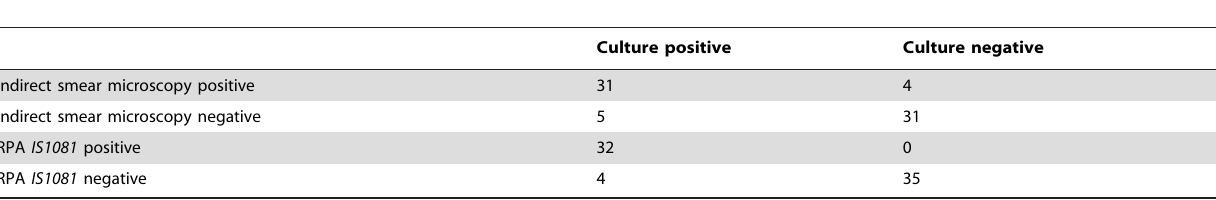
Table 5. Tuberculosis detection by indirect smear microscopy vs RPA IS 1081